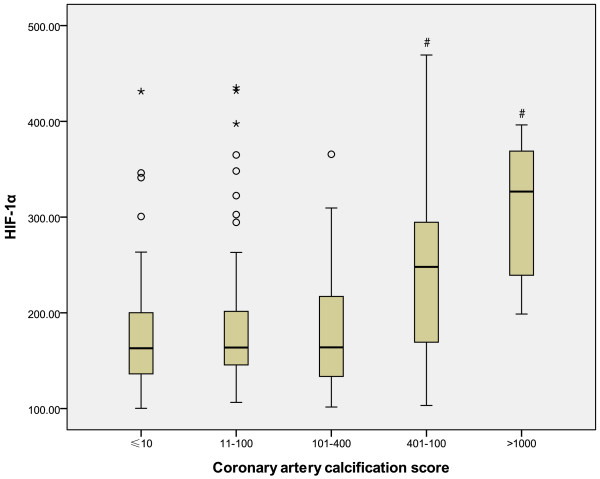
Box and whisker plots illustrate the mean and interquartile ranges of HIF-1α in patients with minimal, mild, moderate, severe, and extensive coronary calcification respectively. Open circles and asterisks show outliers. #P<0.001 compared with minimal, mild and moderate groups.